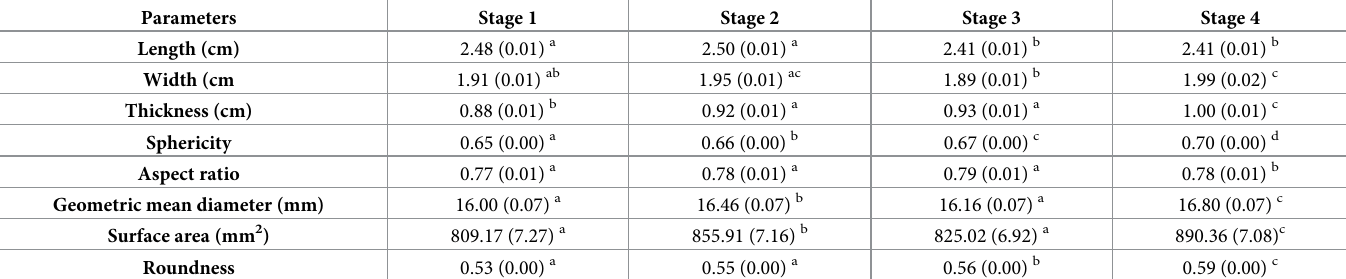
Table 2. Axial dimensional properties and shape of S . madagascariensis seeds at four stages of ripeness. The means for each parameter are reported under the respec- tive stages of maturity followed by the standard error in brackets. Means accompanied by the same letter in a given row are not significantly different (P > 0.05).